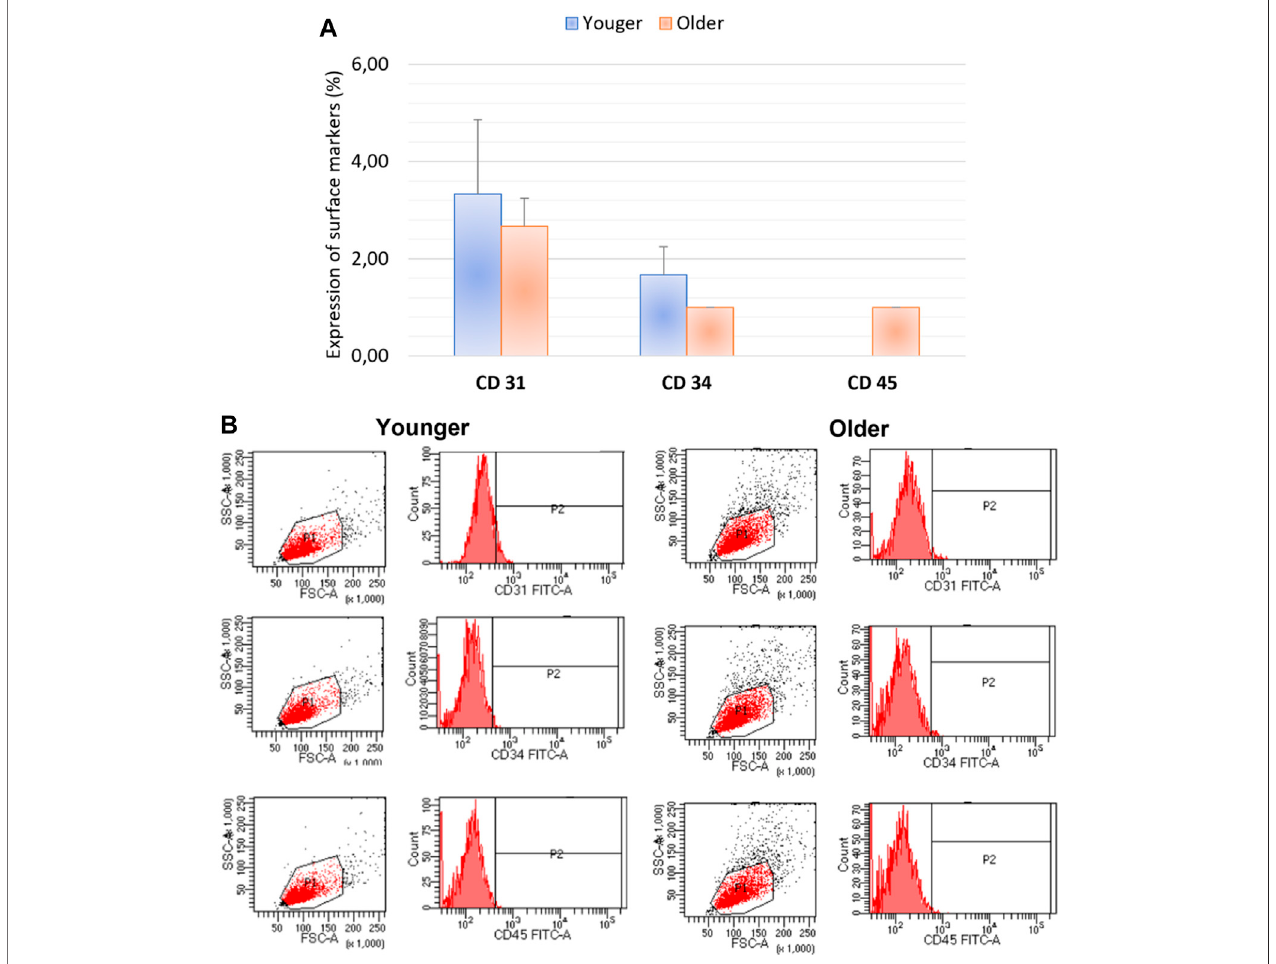
FIGURE6|(A) ComparisonofMSCs ’ surfacemarkersexpressionCD31,CD34,CD45forBMAsclotfromyoungerandolderdonors; (B) representativehistogram of the fl ow cytometry analysis (FACS) of the MSC-related CD surface markers in BMAs clot from younger and older donors. (A,B) demonstrated negative expression of CD31, CD34, CD45 in both MSCs from BMAs clot from younger and older donors.